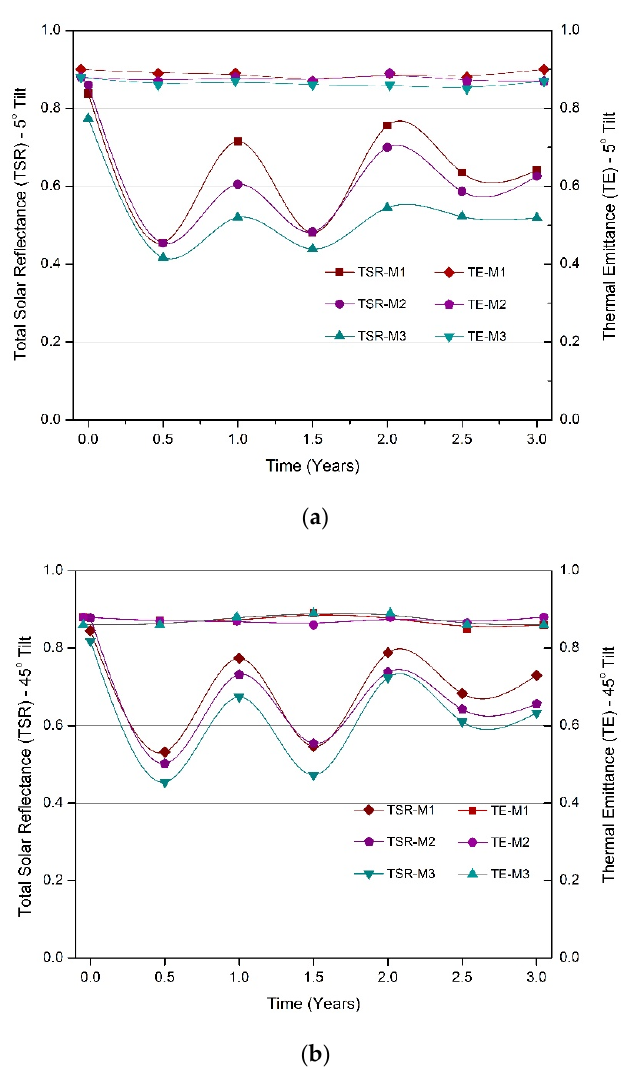
Figure 8. Reflectance and emittance as a function of exposure period at ( a ) 5° tilt and ( b ) 45°